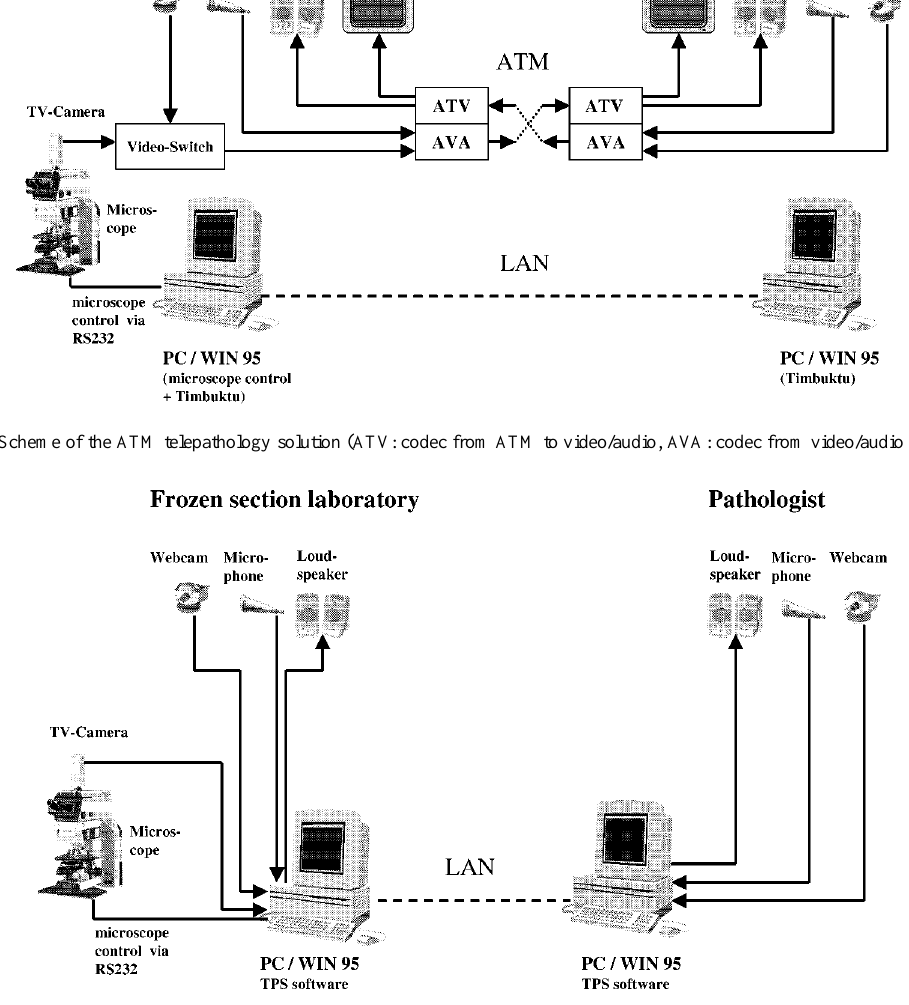
Fig. 2. Scheme of the TPS telepathology